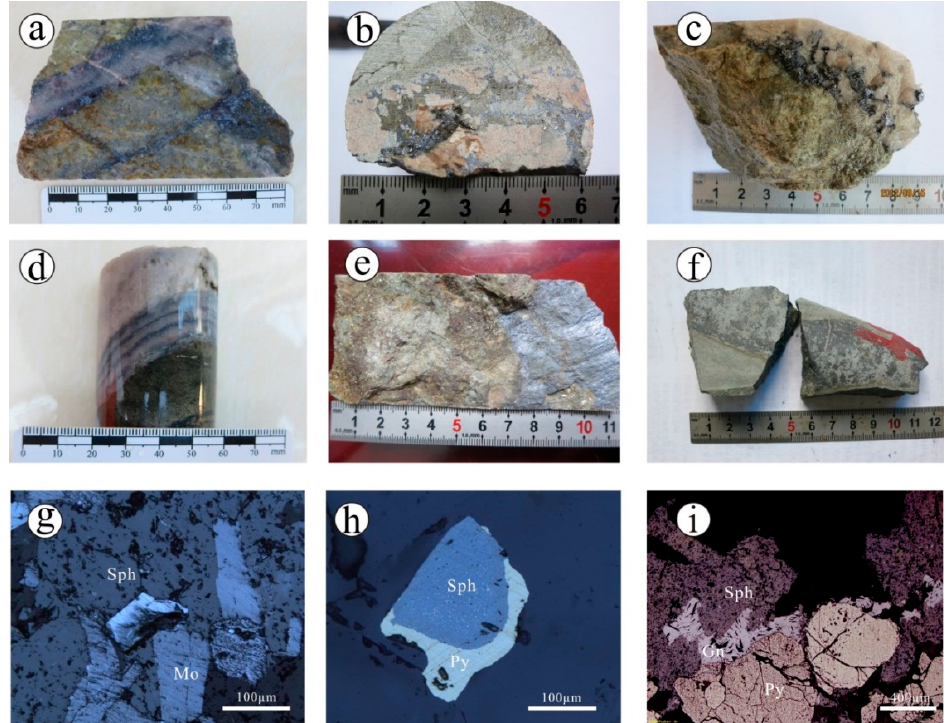
Figure 4. Photographs and photomicrographs showing ore geology of the Mo deposit in Diyanqinamu mine. ( a ): Veined molybdenite-fluorite-quartz ore; ( b ): veined molybdenite-K-feldspar-quartz ore; ( c ): veined molybdenite-quartz ore; ( d ): banded molybdenite-quartz ore; ( e ): molybdenite film in fracture; ( f ): veined molybdenite-quartz-magnetite ore; ( g ): sphalerite coexists with molybdenite; ( h ): sphalerite with chalcopyrite disease structure metasomatismed by pyrite; ( i ): sphalerite coexists with pyrite and galena. Gn: Gelana; Sph: Sphalerite; Mo: Molybdenite; Py: Pyrite.